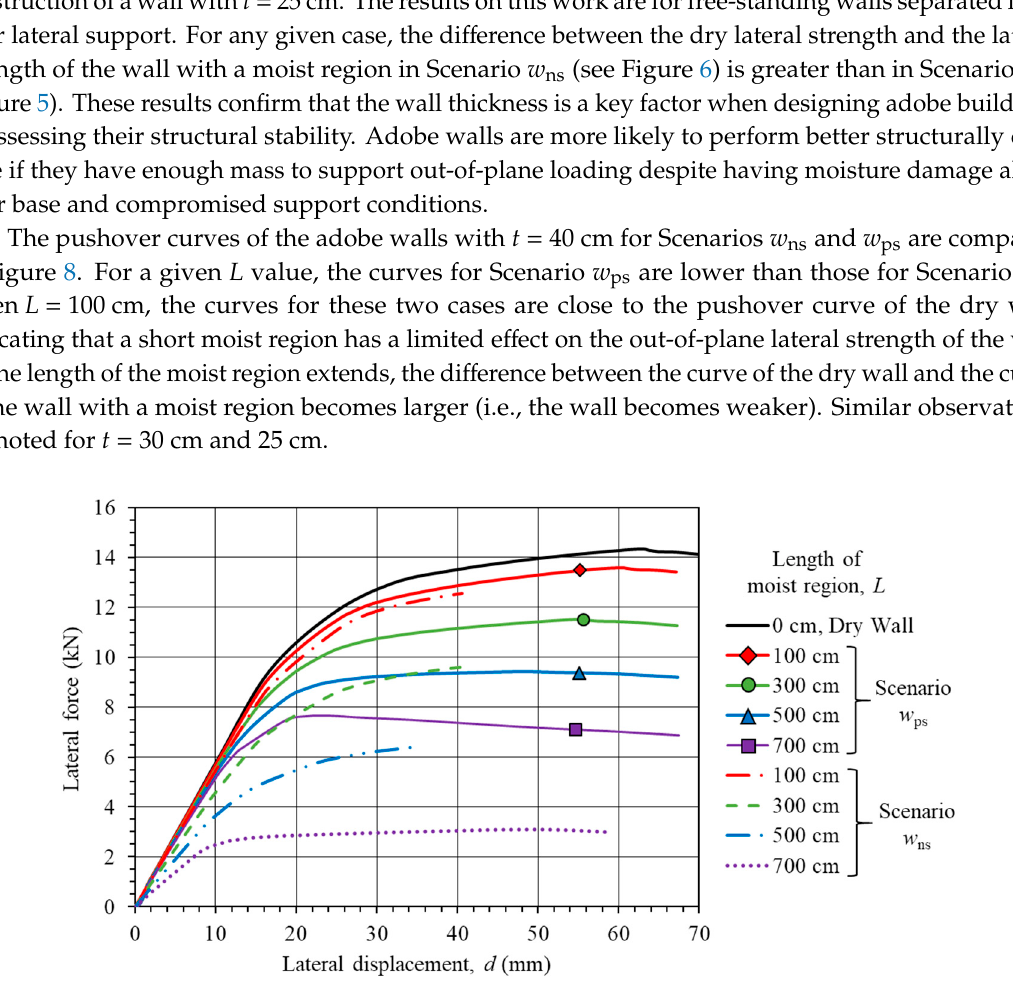
Figure 8. Pushover curves of the adobe wall with t = 40 cm for Scenarios w ns and w ps . Table 3. Out-of-plane lateral strength reduction ratio ( R ).